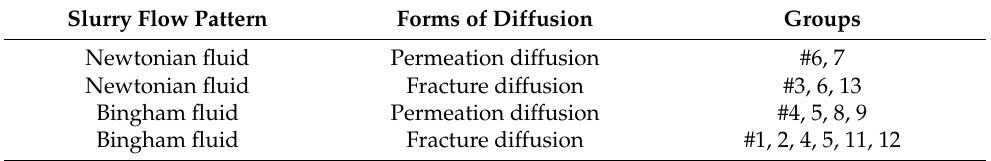
Table 6. Classification of diffusion forms.